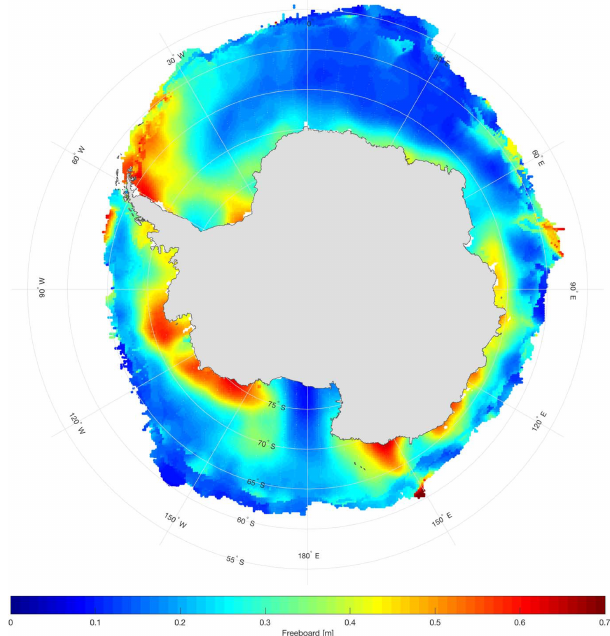
Figure 2. ICESat austral spring mean freeboard, consisting of mea- surements taken in October and November